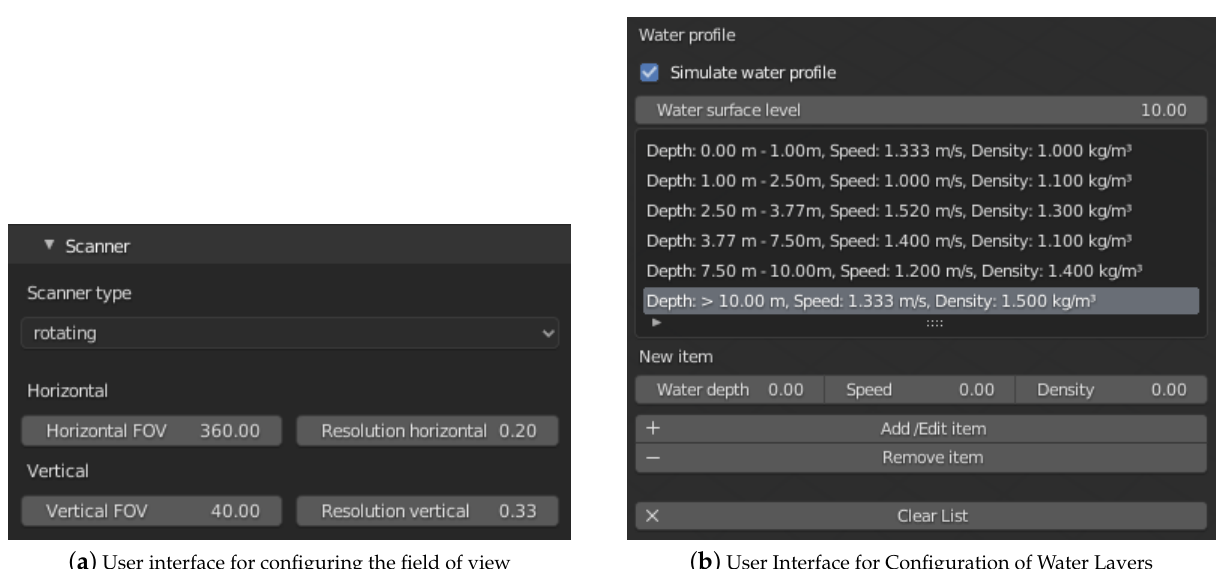
Figure 8. ( a ) The screenshot shows a menu for configuring the scanner type. ( b ) The figure shows a screenshot of the configuration menu for defining water